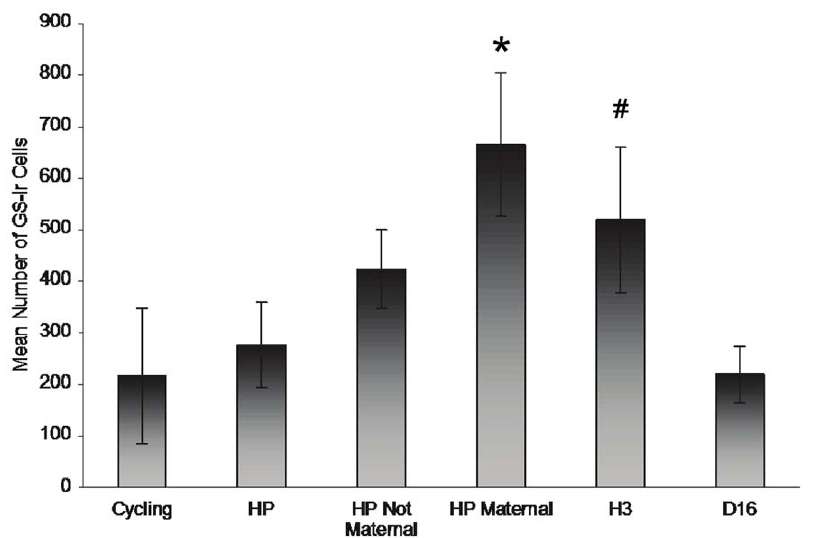
Figure 8. Levels of glutamate and glutamine protein within the Cg2 change with reproductive state. Glutamate (A) or glutamine (B) levels were divided by total protein in picograms per microliter. Asterisks denote a significant increase from cycling and mid-pregnant groups. (Cycling, D1, D16 n=5; Mid-pregnant, Late Pregnant and Hour 3, n=6)